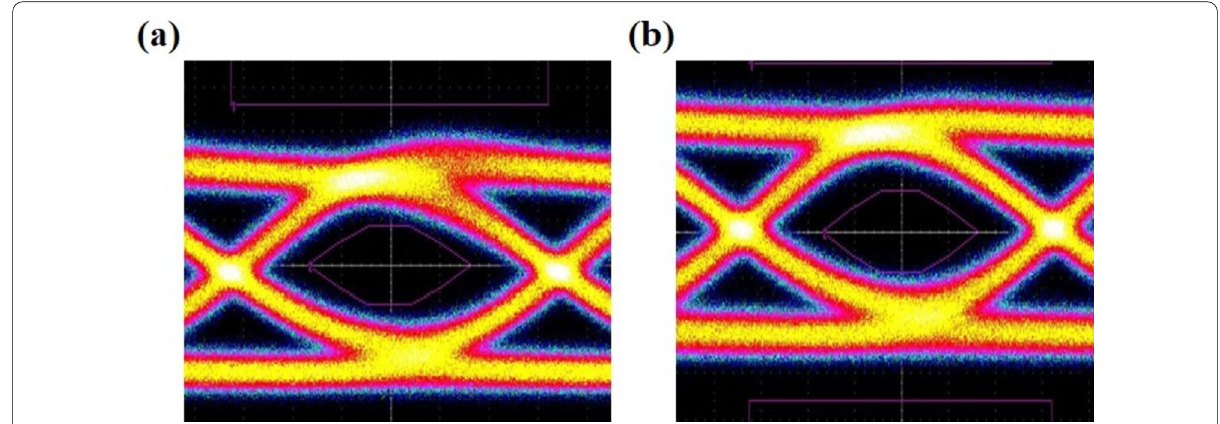
Fig. 10 Eye diagram of OOK signal transmitted by the 850 nm VCSEL at 28 Gb/s under a bias of I